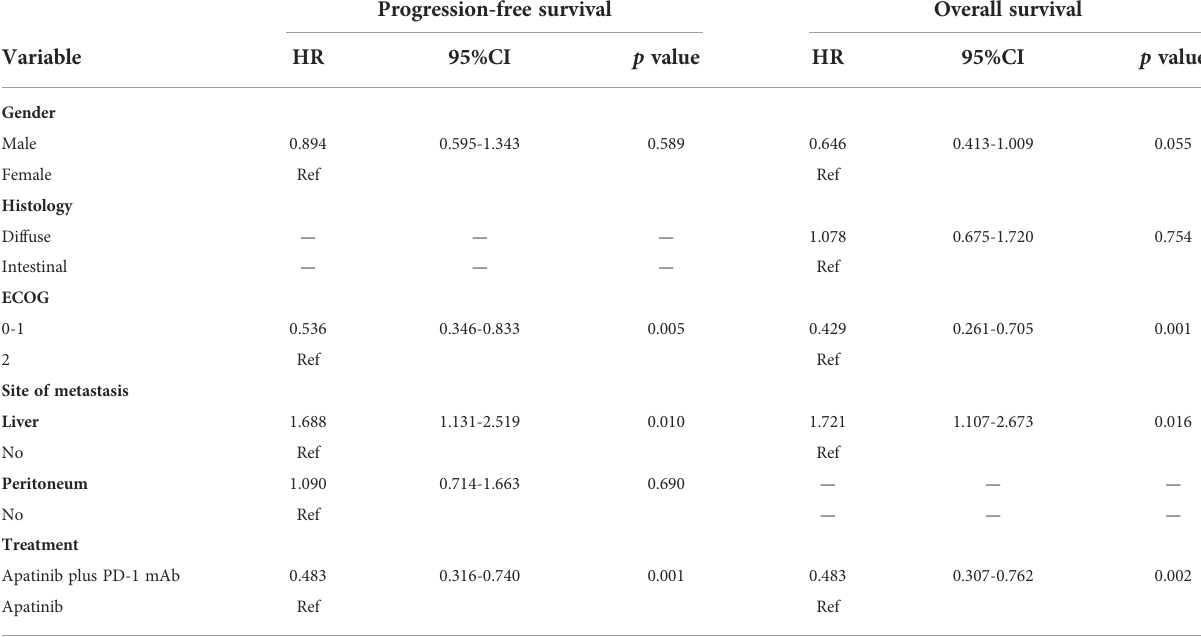
TABLE 3 Multivariate analyses of progression-free survival and overall survival for apatinib plus PD-1 mAb versus apatinib monotherapy.